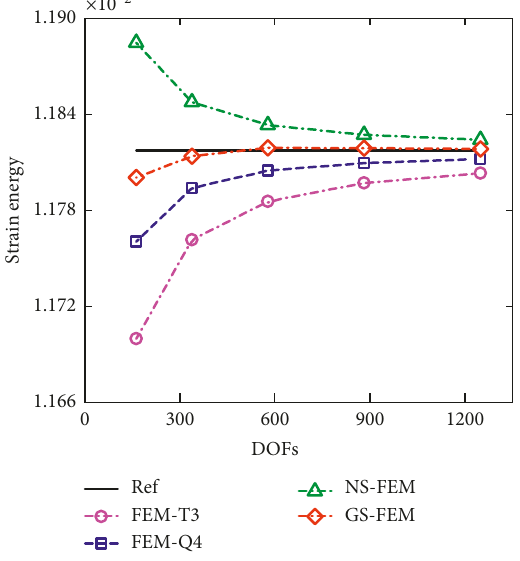
Figure 19: Convergence of strain